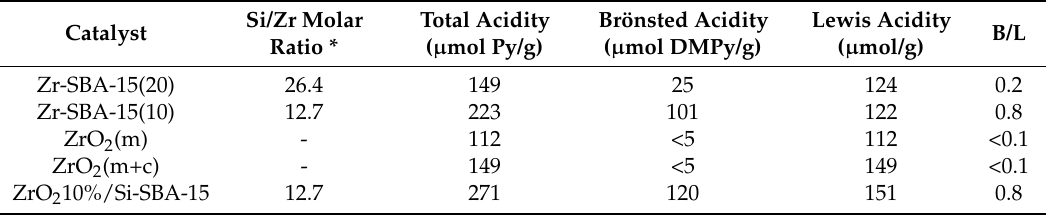
Table 2. Surface acid properties of the investigated using the chromatographic pulse method.